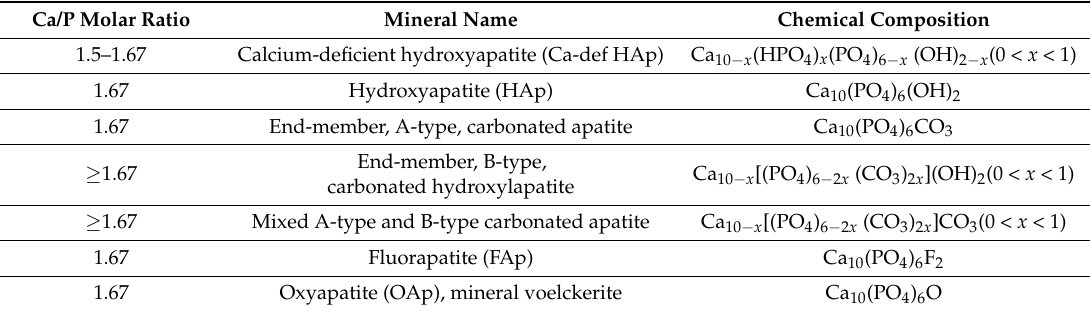
Table 1. The main minerals of the Apatite group, their Ca/P molar ratio and chemical composition. Ca/P Molar